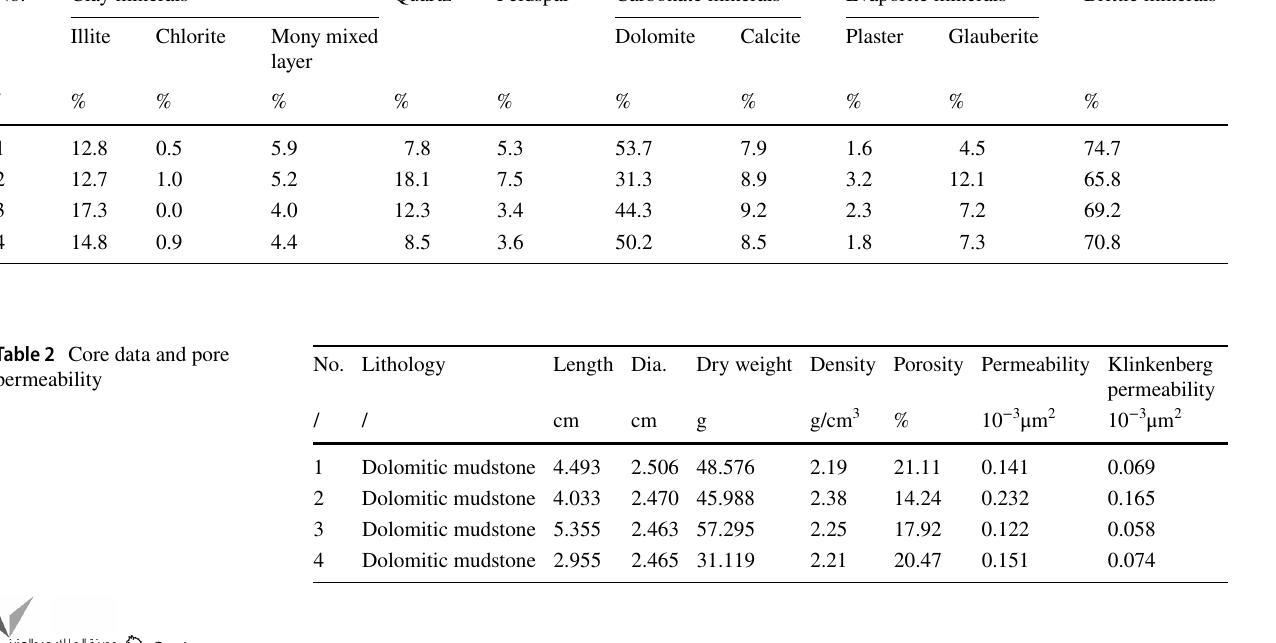
Table 1 Core mineral composition No.